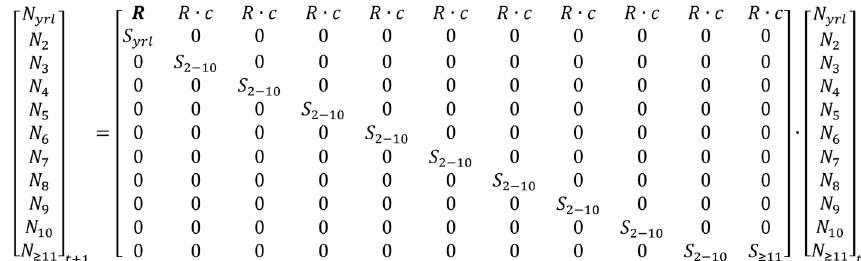
Figure 5. Population projection matrix used for simulating Caprinae population growth and the abundance of adult females. The first recruitment entry (bold R) is a necessary computational step to correctly represent reproduction, and account for the observer misclassifications of yearling male and females as adult females. Symbols indicate the following: R = recruitment, S = adult female survivorship, c = 0.5 (sex ratio), N = Age